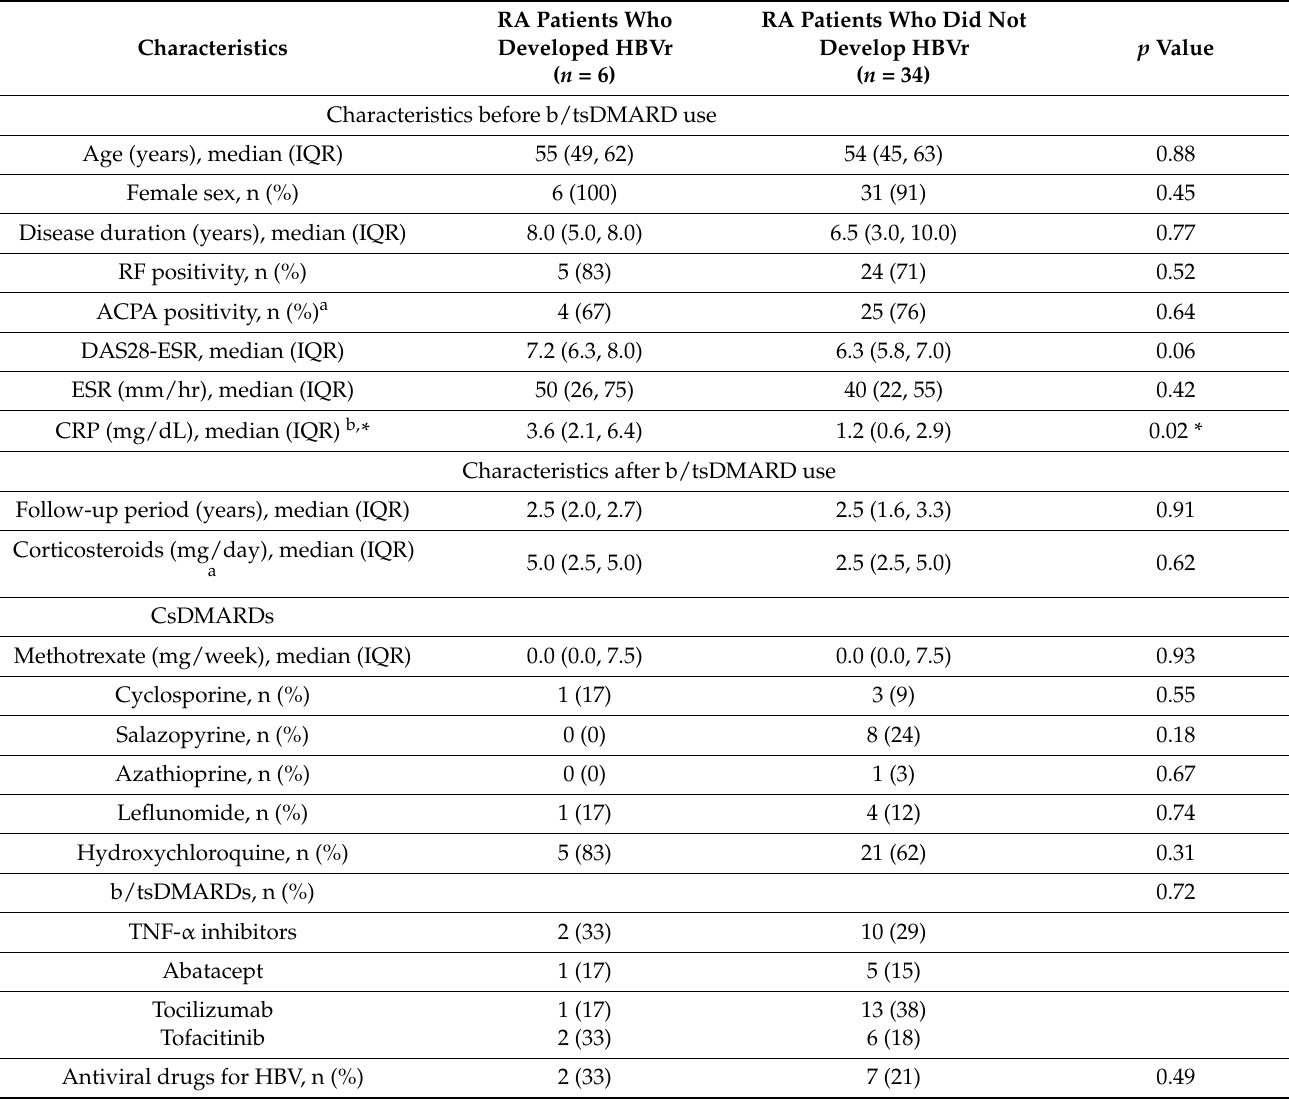
Table 3. Characteristics of RA patients who developed HBVr and those who did not before b/tsDMARD dose